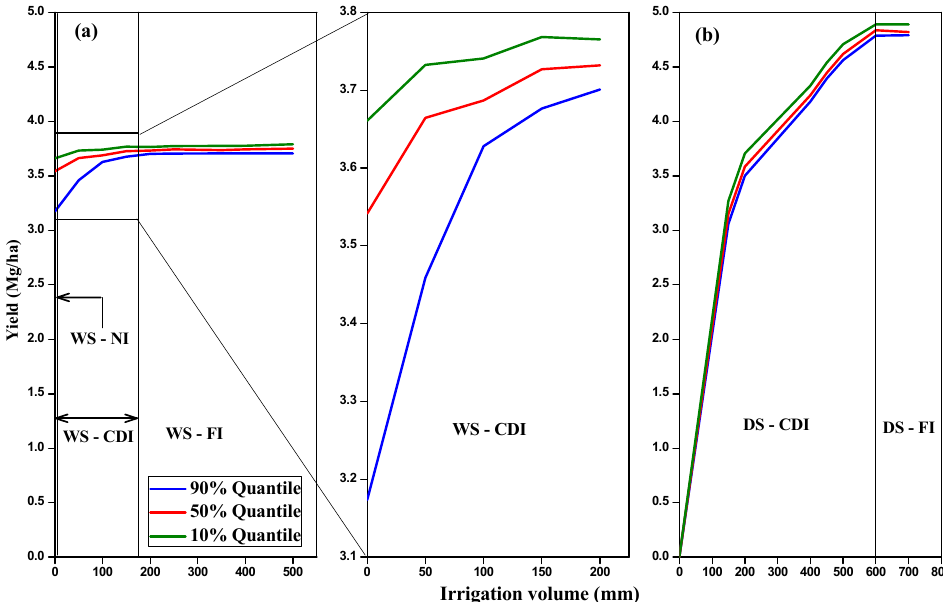
Figure 6. Stochastic crop-water production function for: ( a ) rainfed and supplemental irrigated systems in the wet season; and ( b ) optimized conventional irrigation system in the dry season for maize in Dapaong.